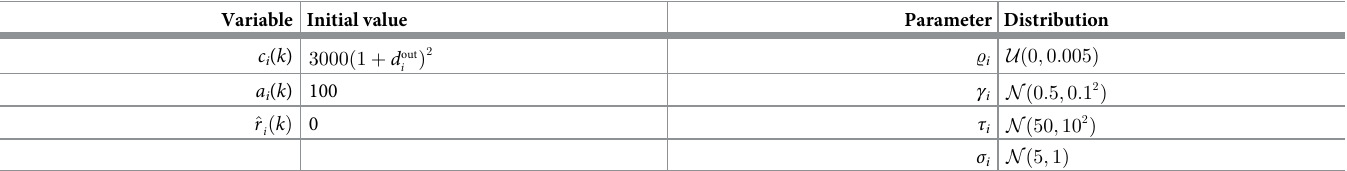
Table 1. Market initialization and selected distribution for each of the